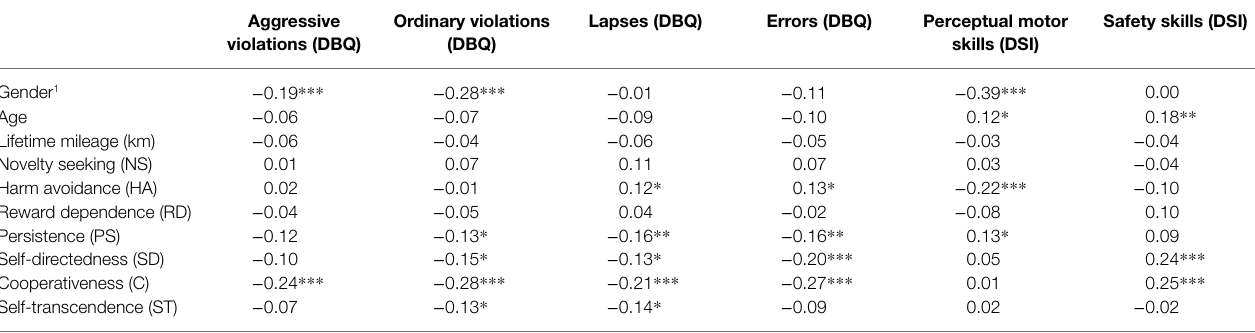
TABLE 2 | Pearson product–moment correlations between driving-related variables (DBQ and DSI scales), background variables (gender, age, mileage) and TCI scale scores. Aggressive violations (DBQ)